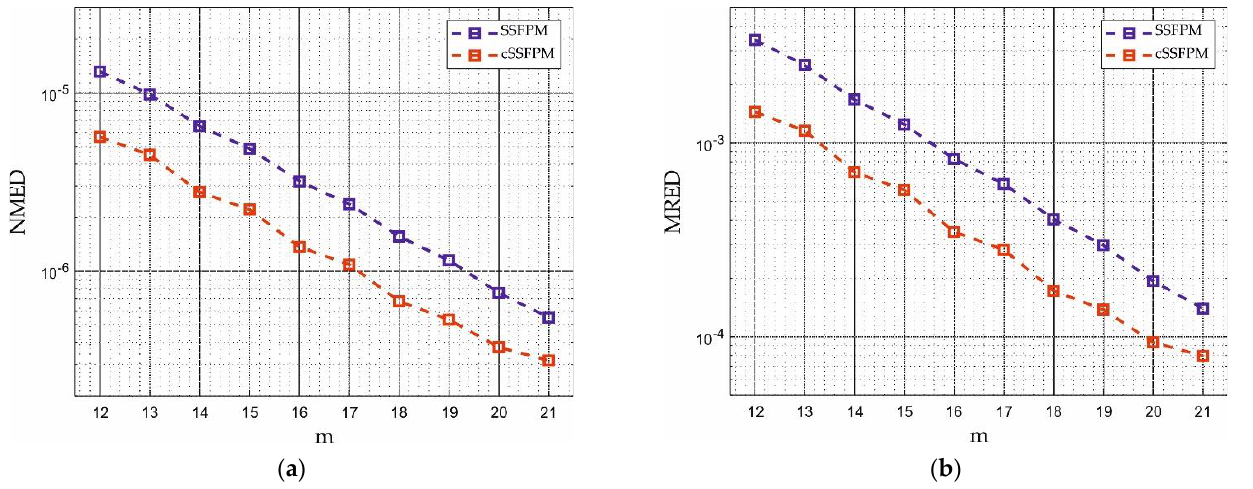
Figure 8. Behavior of ( a ) NMED and ( b ) MRED as function of m for the SSFPM and the cSSFPM.